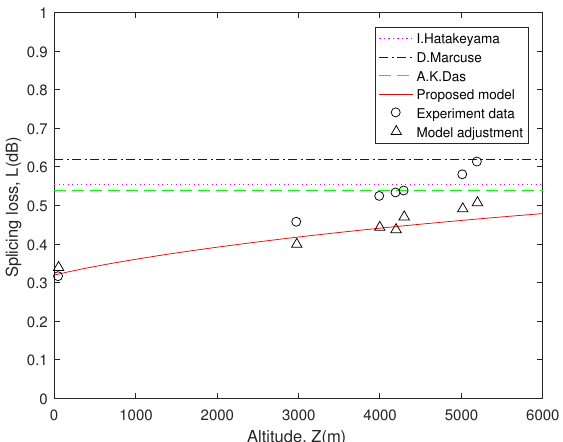
Figure 8. Splice loss versus altitudes, the theoretical values are obtained according to the optimum fusion conditions given by the respective models, and the field fusion-splicing has been carried out in the high altitude